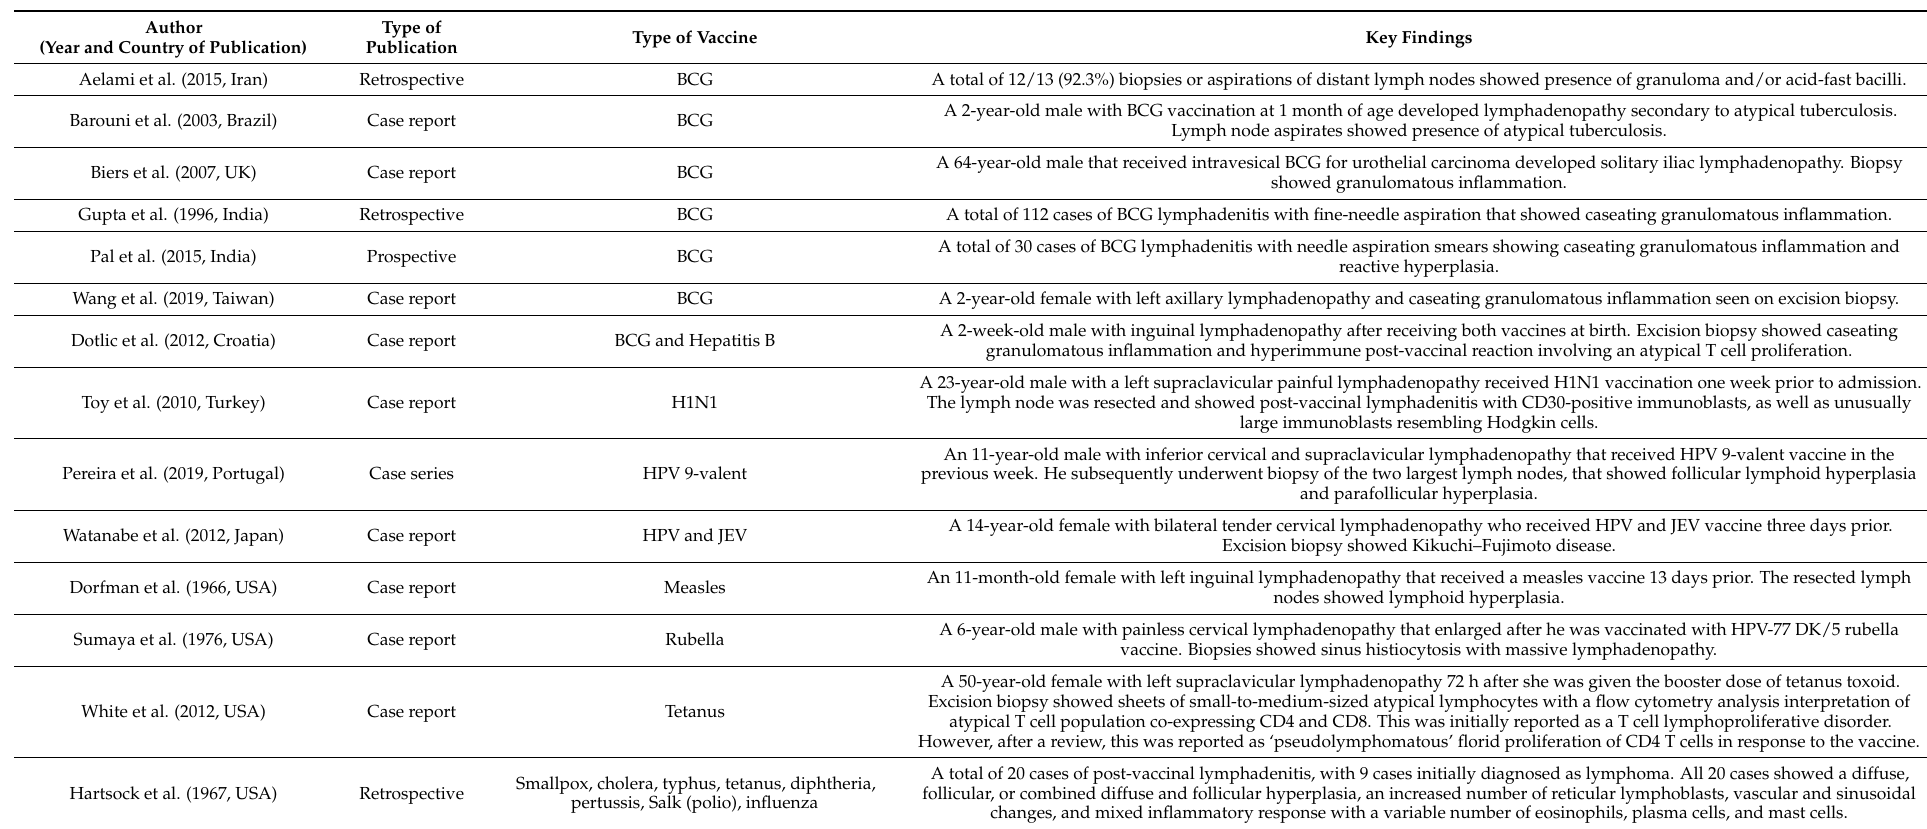
Table 4. Findings from non-COVID-19 vaccine-associated lymphadenopathy. BCG, bacillus Calmette–Gu é rin; HPV, human papillomavirus; JEV, Japanese encephalitis